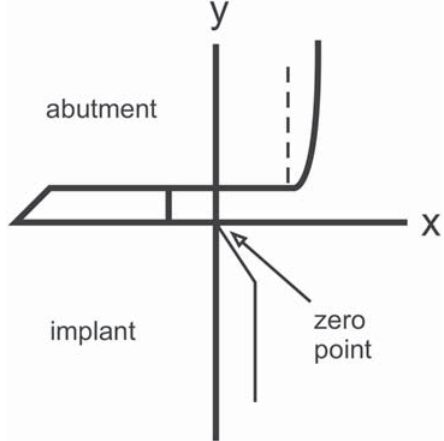
Figure 4- Reference points for measurement of the